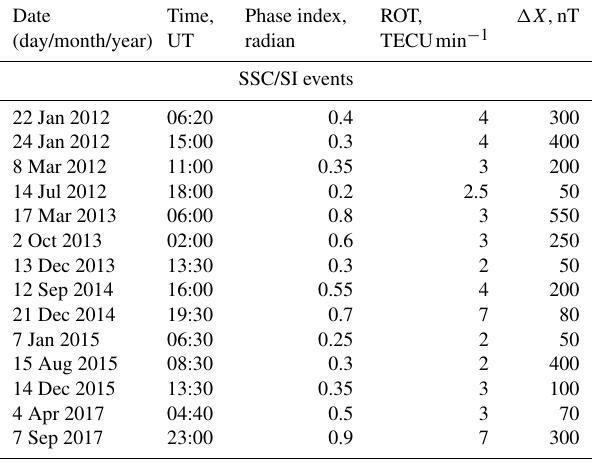
Table 3. The values of the phase scintillation index, ROT, deter- mined from the GPS receiver at NYA station, and corresponding levels of the geomagnetic field disturbance ( (cid:49)X ) during SSC/SI events.